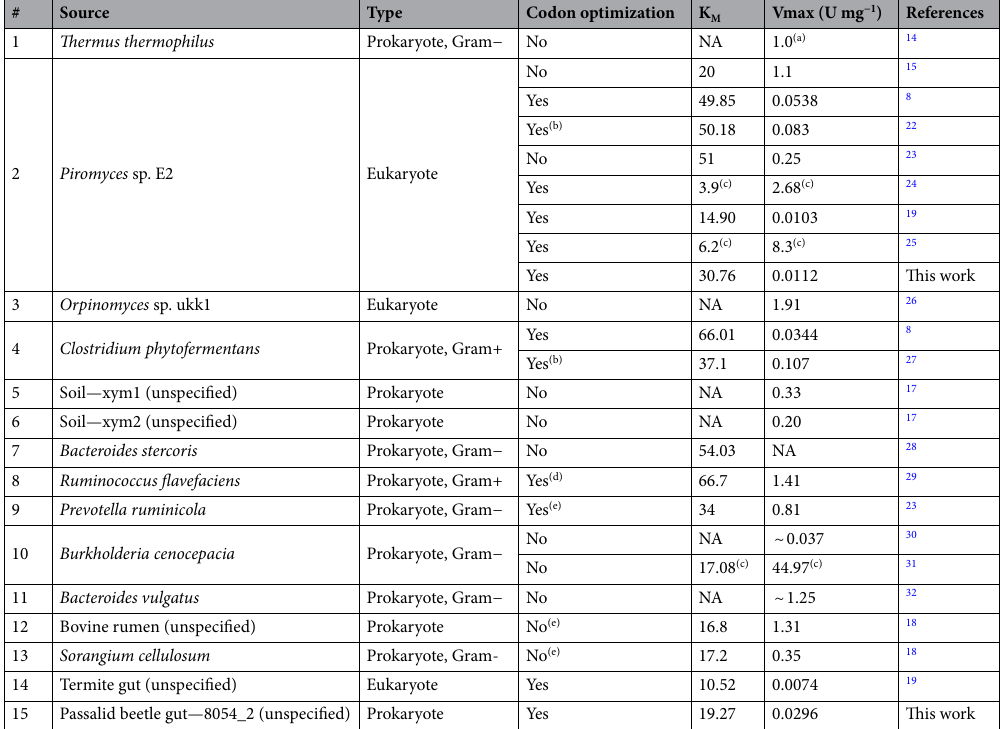
Table 1. Literature data on d-xylose isomerase enzymes with characterized kinetic properties that were actively expressed in Saccharomyces cerevisiae . Kinetic parameters were determined directly from cell lysates or otherwise stated. NA not available. a Determined by measuring the conversion of fructose to glucose. b And also random mutagenesis. c Determined from purified enzymes. d And also site-directed mutagenesis and modifications 5 ′ -end of the gene. e And also evolutionary